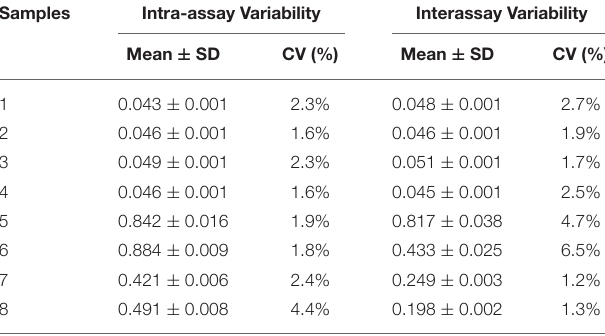
TABLE 1 | Reproducibility of the pELISA in detecting IBV-specific antibodies.